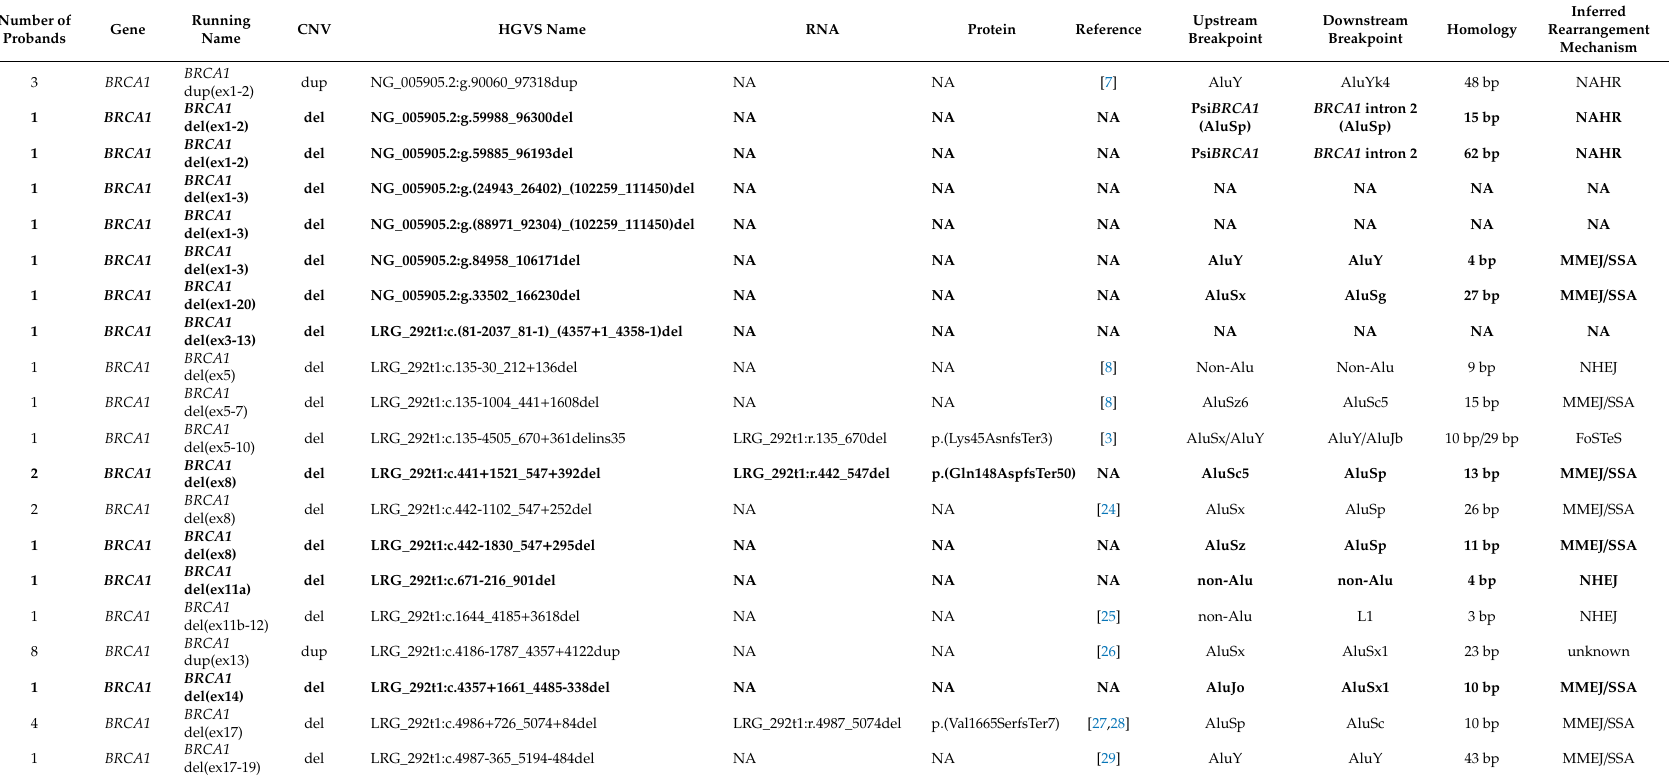
Table 1. List of the Hungarian large genomic rearrangements (LGR)